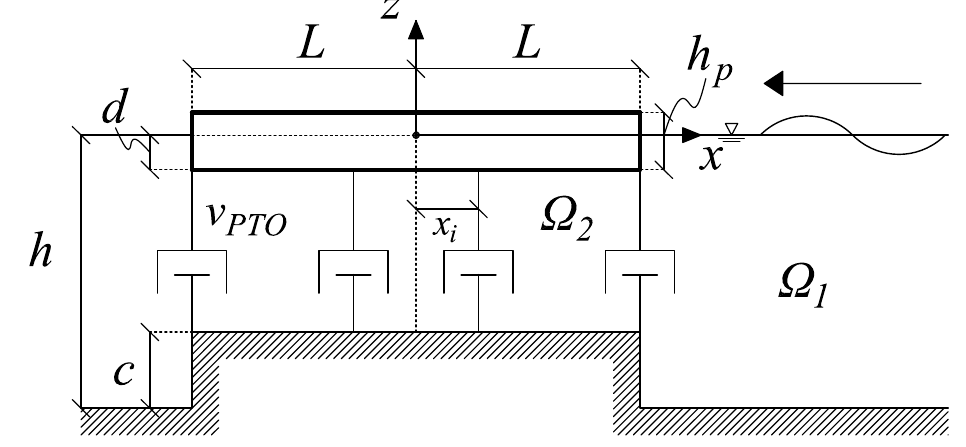
Figure 2. Side view of the floating plate WEC. The power take-off (PTO) mechanisms are located at points x i , i = 1,..., M